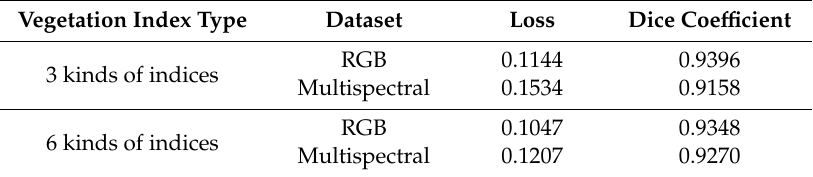
Table 5. Model average